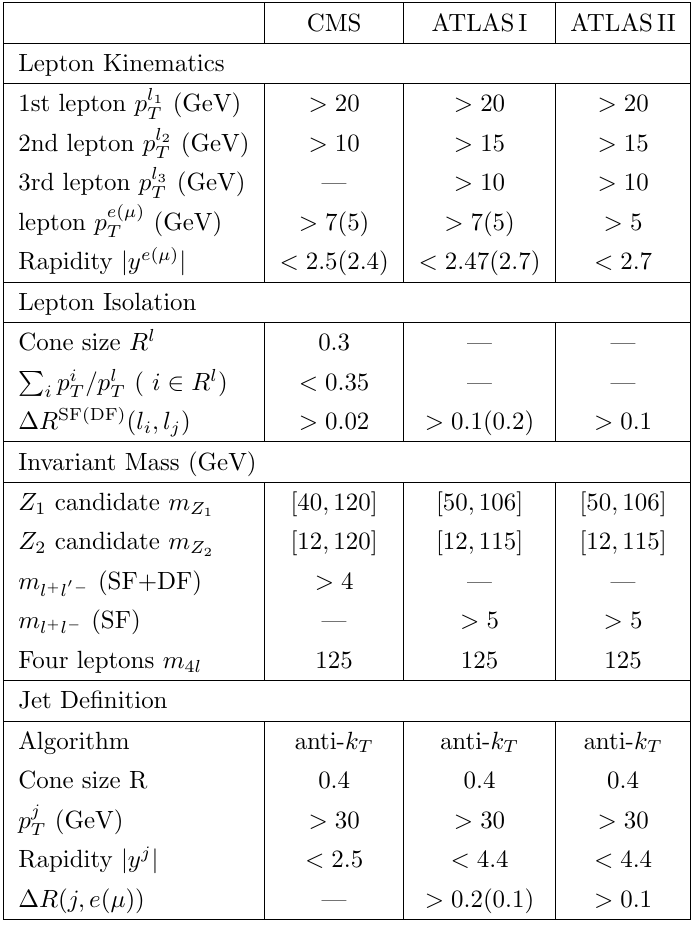
Table 1. Fiducial cuts for (cid:12)nal state leptons and jets in the calculations of NNLO JET (based on the measurements of CMS [32, 33], ATLAS I [30] and ATLAS II [31]). Jet de(cid:12)nitions do not apply